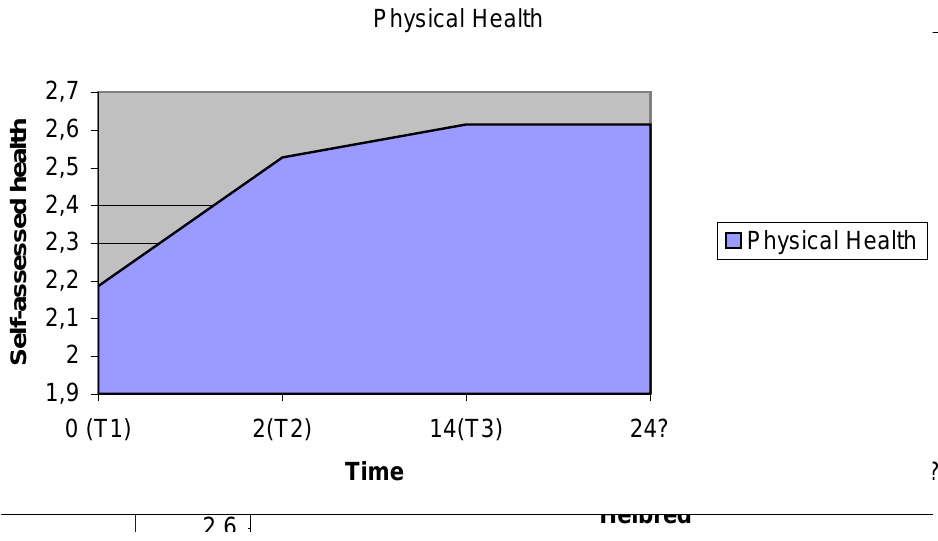
FIGURE 10. The almost perfect square curve[19] for physical health documenting self-assessed physical healing with clinical holistic medicine. The patients were measured with QOL 5[20] before treatment (T1), immediately after (T2), and 1 year after (T3). Time is in months. (Please notice the inverted scale here).